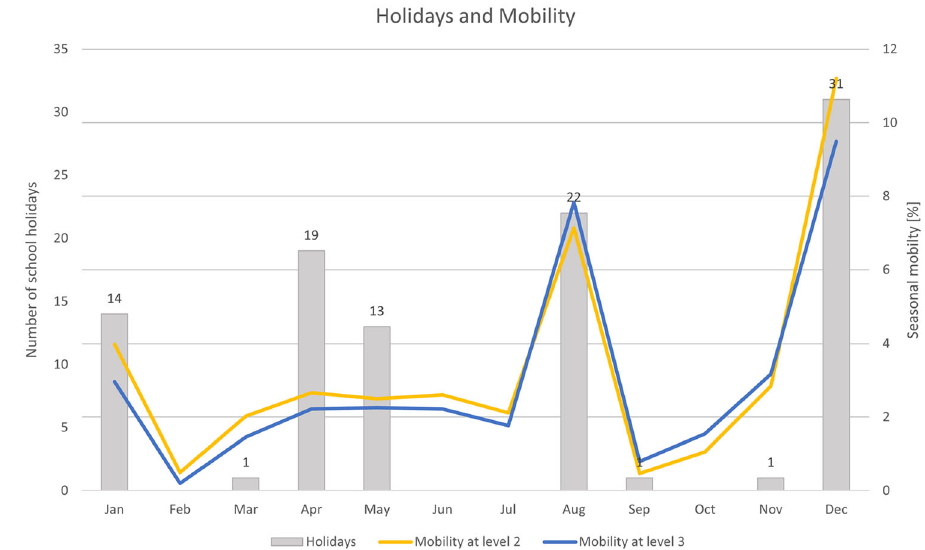
Fig. 8 Relationship between seasonal mobility and public and school holidays (obtained via Lai et al., 2020b; see “ Data availability ” section). Mobility was averaged per month from 2011 to 2013 across all administrative